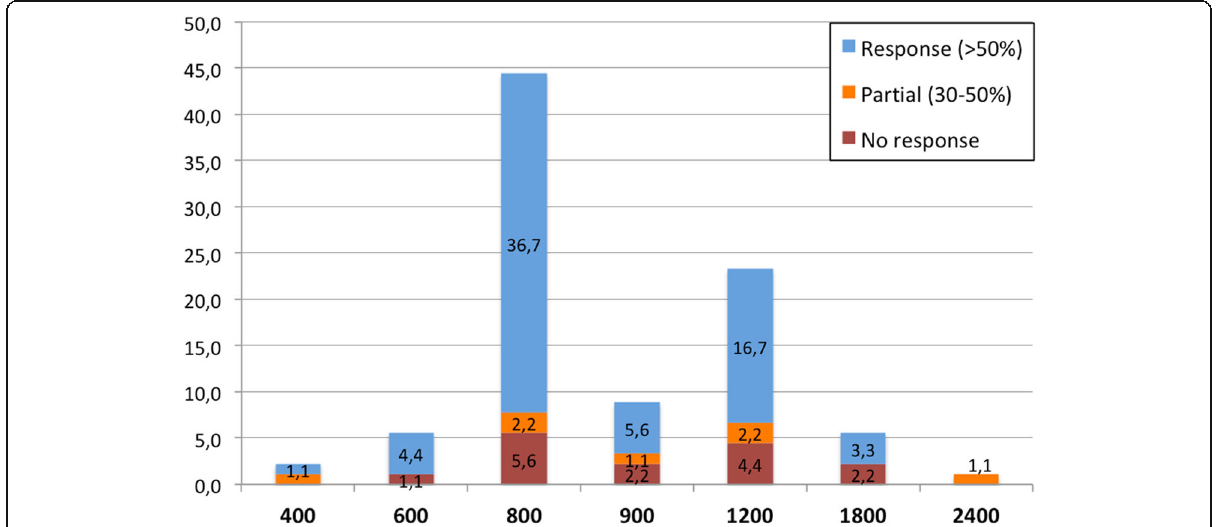
Fig. 2 Clinical response to gabapentine. Blue bars: > 50% response, orange bars: 30 – 50% response, red bars: no response. Percentage represents % of patients treated with